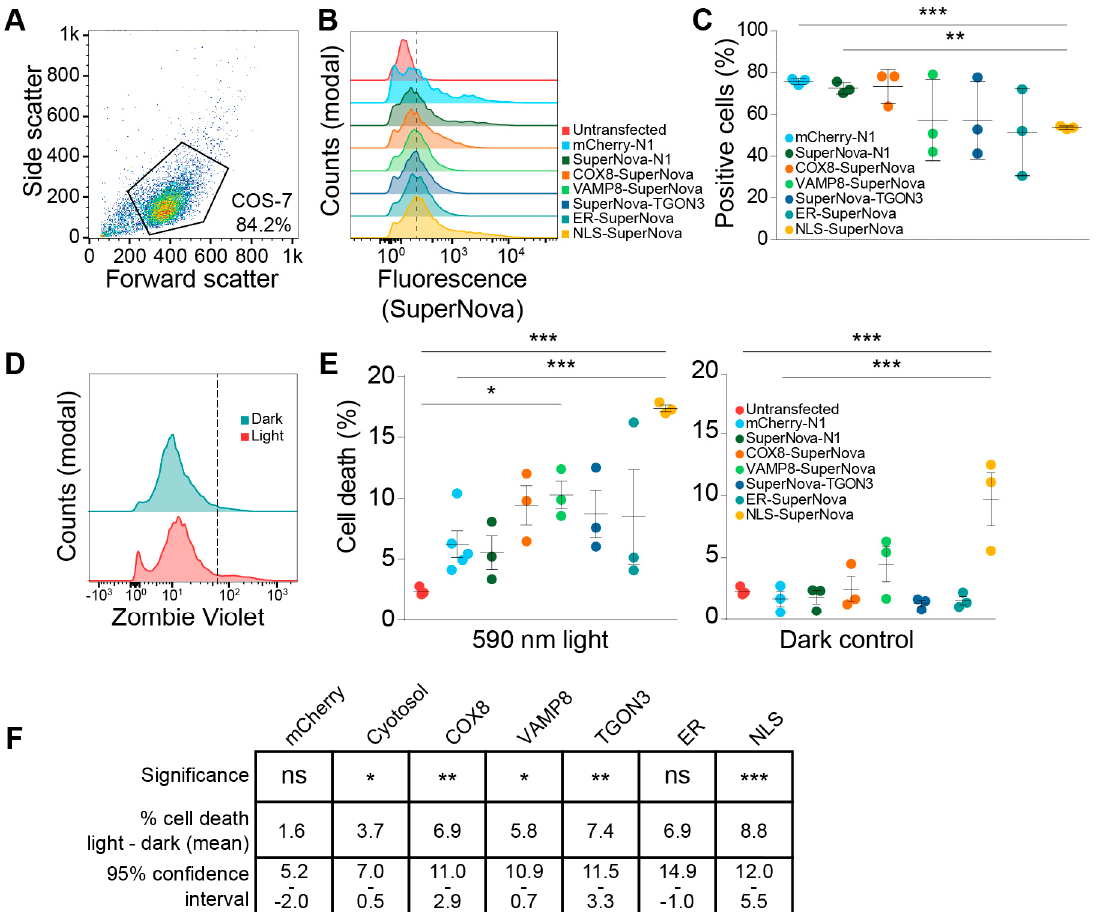
Figure 3. SuperNova fusion construct expression levels and viability upon light exposure. ( A ) Representative scatter plot of COS-7 cells. Polygon indicates gating to exclude debris from cells. ( B ) Fluorescent intensity histograms of SuperNova in COS-7 cells expression SuperNova fusion proteins after gating as shown in A . Dotted line indicates gating for SuperNova-positive cell population based on background fluorescence of untransfected cells. At least 20,000 cells were included in each measurement. ( C ) Percentage of COS-7 cells positive for SuperNova as shown in B , each dot represents a technical repeat. Analyzed with paired one-way ANOVA with Tukey post-hoc test (** p < 0.01; *** p < 0.001). ( D ) Representative fluorescent intensity histograms of COS-7 cells expressing SuperNova fusion protein (cytosolic) after stimulation with 590 nm excitation light for 1, 4, or 24 h and stained with the Zombie Violet cell viability dye. Dotted line indicates gating for Zombie Violet-positive cell population based on background fluorescence of unstained cells (not shown). ( E ) Percentage of cell death in COS-7 after stimulation with 590 nm excitation light for 24 h, each dot represents a technical repeat. Control cells were kept in the dark for 24 h. At least 20,000 cells were included in each measurement. Analyzed with unpaired one-way ANOVA with Dunnett post-hoc test comparing all conditions to the untransfected cells and to mCherry-N1 (* p < 0.05; *** p < 0.001). ( F ) Table showing analysis of data from panel E . Confidence intervals shown are 95% of average di ff erence in cell death (%) between dark and 590 nm light exposure. Analyzed with unpaired one-way ANOVA with Dunnett post-hoc test (ns: not significant; * p < 0.05; ** p < 0.01; *** p <